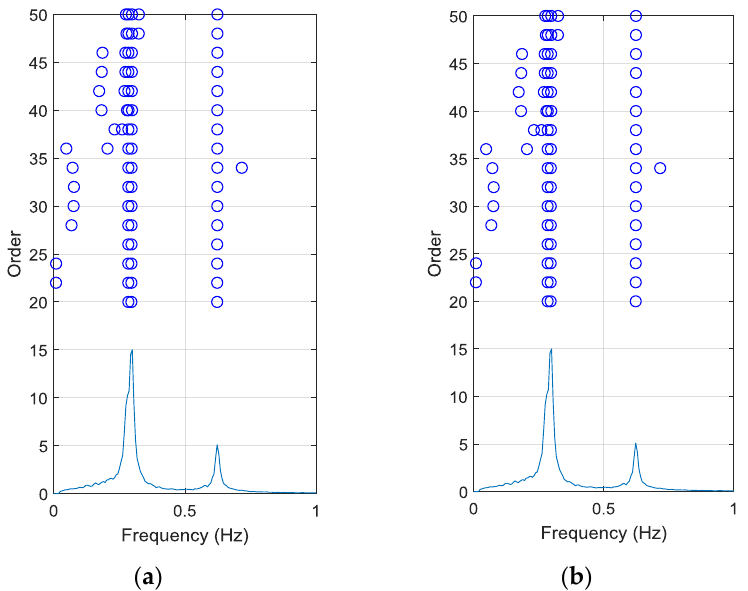
Figure 5. Stabilization charts (circles denote poles determined by the stochastic subspace identification (SSI) method and solid lines denote the average power spectral density of the measured acceleration data): ( a ) Harbor View 1502 and ( b ) Central Park 103.